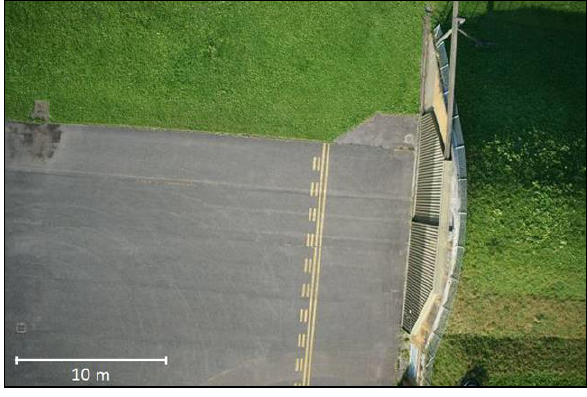
Figure 5: Orthoimagery of an airplane hangar (15 m wide) taken with the camera integrated in the laser scanning payload.